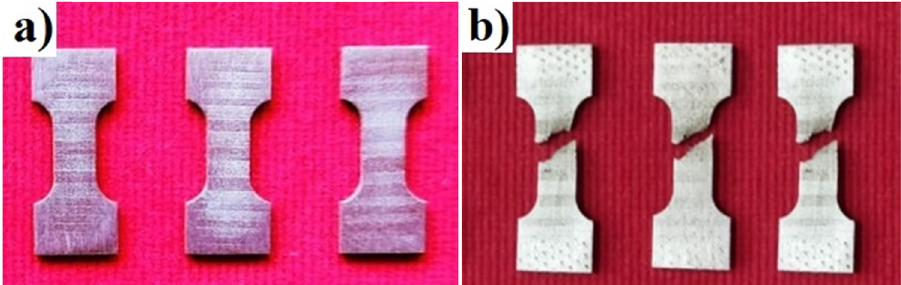
Figure 12: Fractured miniature tensile specimens: ( a ) before testing and ( b ) after